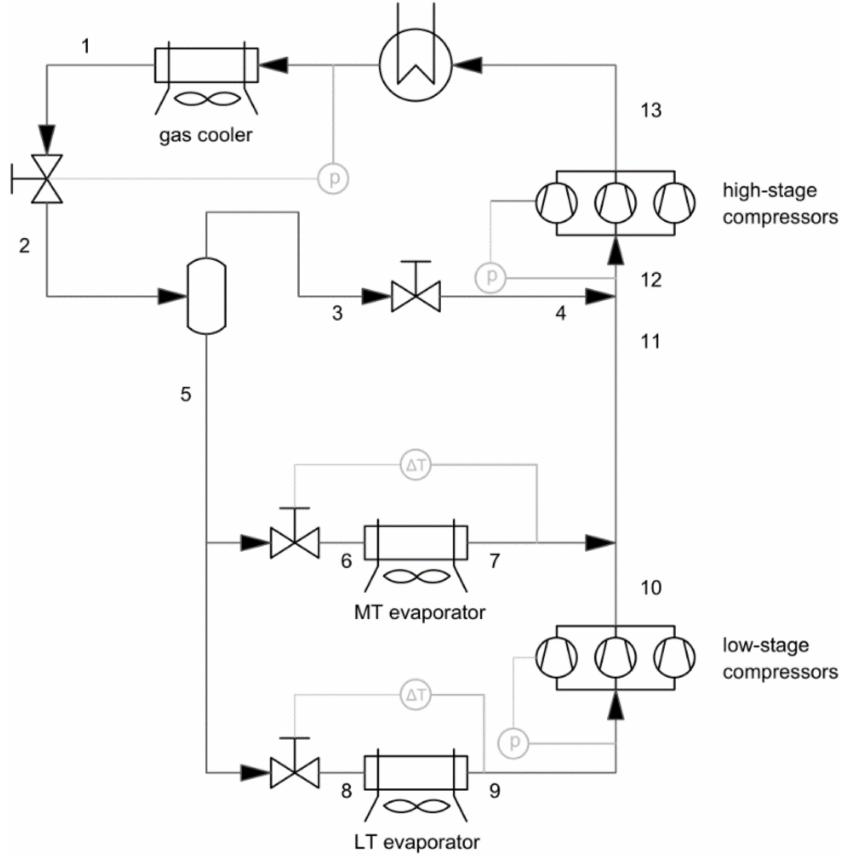
Figure 3. Scheme of CO 2 transcritical